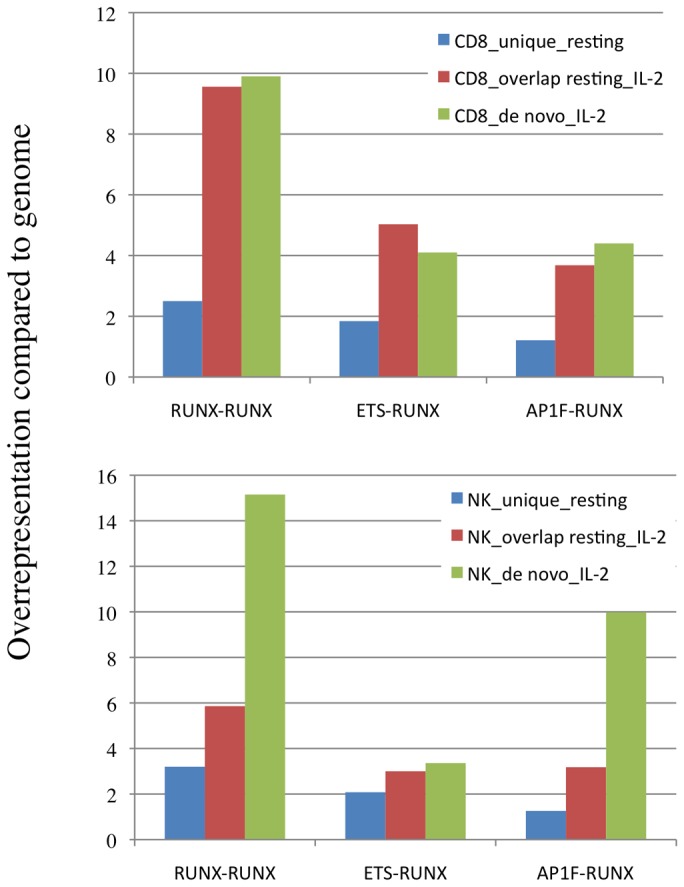
Increased enrichment of RUNX-RUNX, ETS-RUNX and AP1-RUNX modules in uniquely Runx3-bound regions of IL-2-activated compared to resting cells.Histograms show the degree of enrichment compared to genome of the above modules in Runx3 peaks unique to resting cells, overlapping peaks in resting and IL-2-activated cells and de novo peaks unique to IL-2-activated cells.